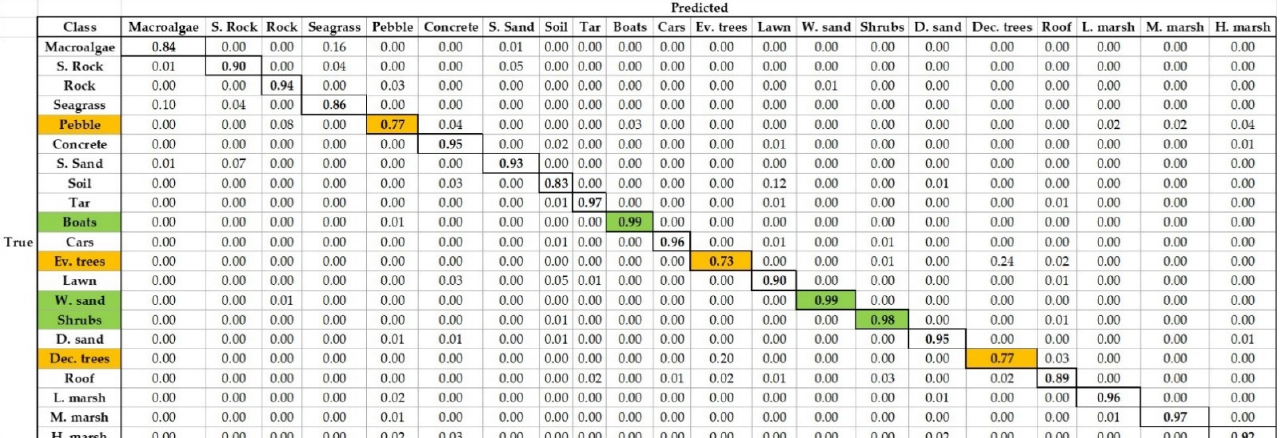
Figure 13. Confusion matrix obtained by the random forest classification of the green waveforms’ features, infrared intensities, and elevations. The three highest and three lowest class accuracy values are highlighted in green and orange, respectively. S. = submerged, Ev. = evergreen, Dec. =